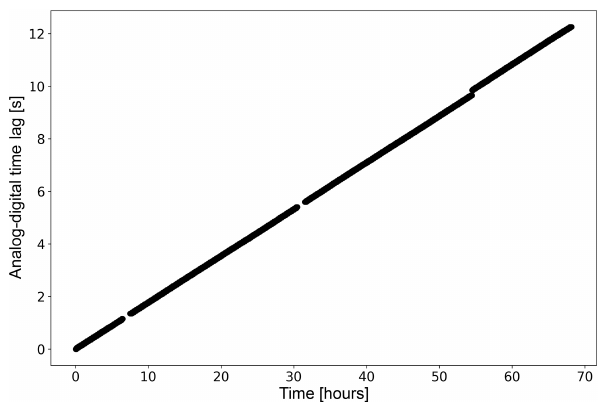
Figure 9. Evolution of time lags between two replicates of the same variable ( u wind component, but identical results were obtained with v and w ), one collected with the SAT native digital format and one collected via analog outputs from the SAT. Data were collected in two files roughly 70h long and then split into 30min chunks for the computation of time